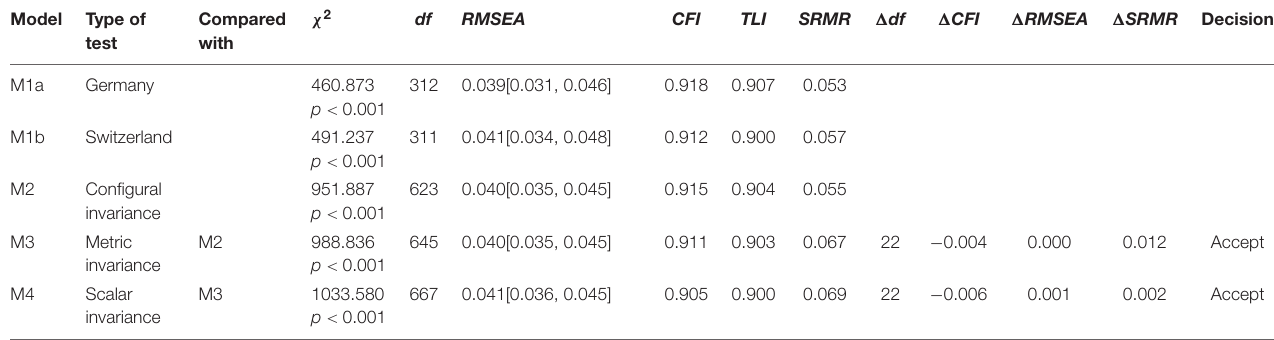
TABLE 2 | Evaluations of multigroup measurement invariance across countries (MGCFA MI). Model Type of test